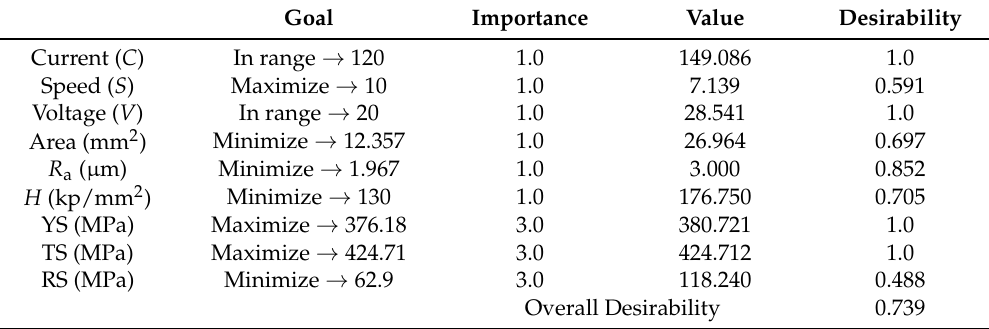
Table 13. The fourth criterion considered: welded joint strength based on tensile strength, yield stress and residual